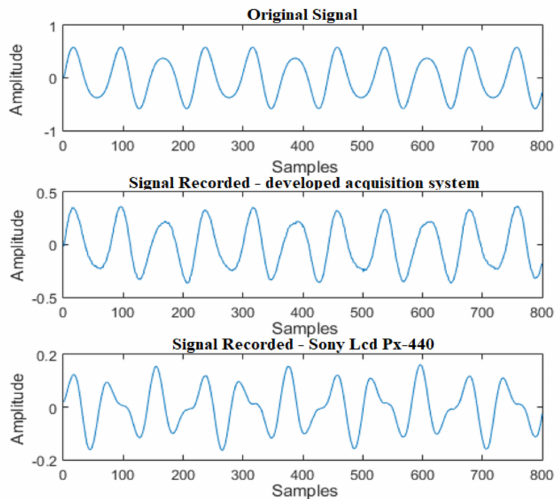
Figure 16. Acquisition of a two-tone signal: F1 = 600 Hz/F2 = 1000 Hz.